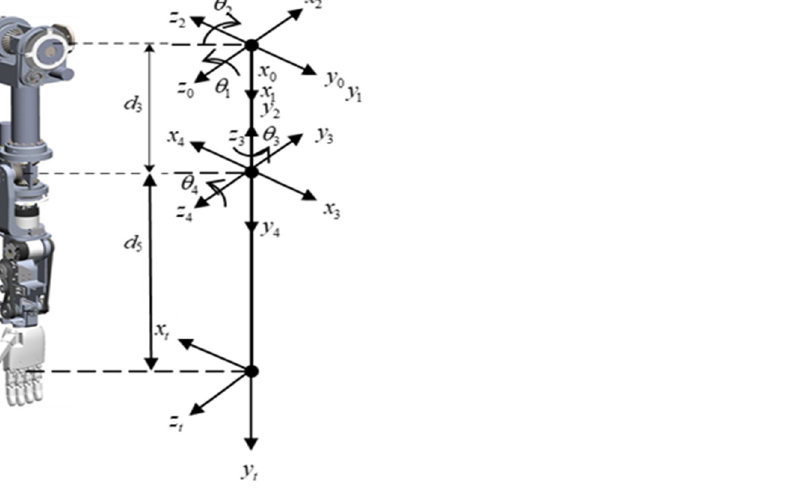
Figure 1. Three dimensional (3D) model and Denavit-Hartenberg (D-H) coordinate of the low-cost humanoid manipulator. Table 1. The parameter list of D-H.